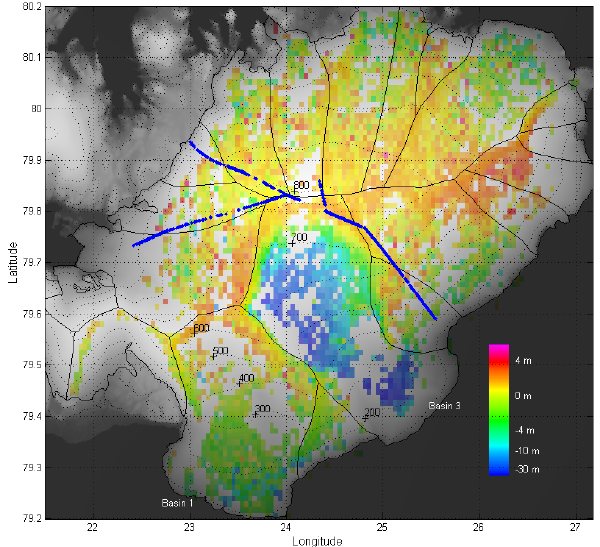
Figure 12. Three year height change estimates illustrated for differ- ent footprints across Austfonna. Each coloured pixel represents an average of the height change estimates in that footprint ( ∼ 1km 2 ). Note the colour scale is very nonlinear to better represent the height increase of a few metres at higher elevations, and in the northeast, and still illustrate the large height loss of ∼ 30m in the lower area in basin 3 due to the surge which began in 2012. The blue dots indi- cate the positions where surface elevation was measured with GPS in the spring of 2011 and again in